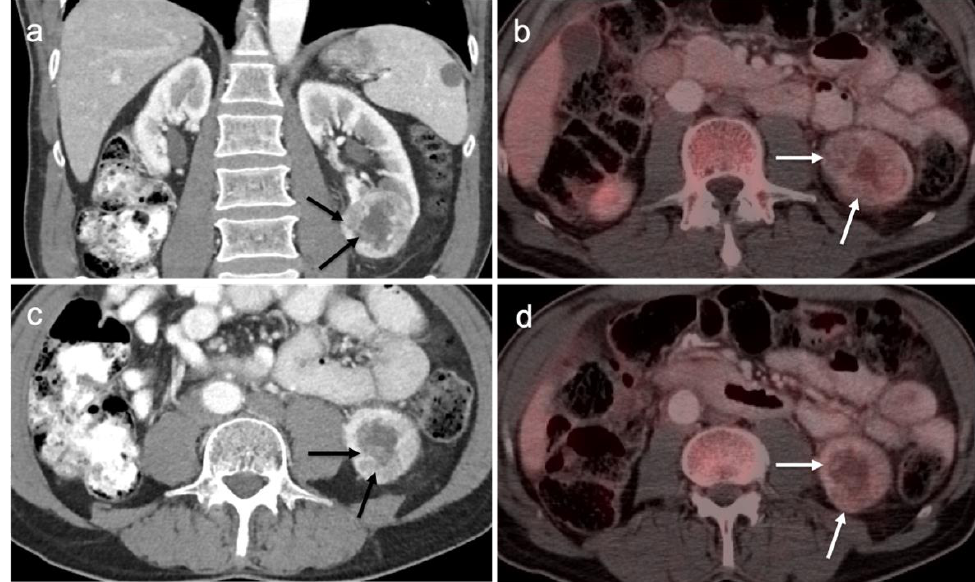
Figure 47. Renal oncocytoma on contrast enhanced FDG PET-CT. ( a , c ) Contrast-enhanced CT shows a heterogeneously enhancing mass (black arrows) in the left kidney; ( b , d ) On FDG PET-CT, the oncocytoma would be difficult to appreciate without the concurrent contrast enhanced CT and is similar in metabolic activity to the remainder of the normal renal parenchyma (white arrows). This was an oncocytoma, but a renal cell carcinoma can have a similar in appearance.